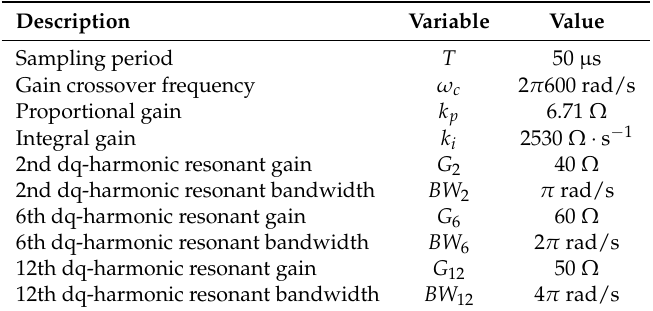
Table 2. PI and PR control